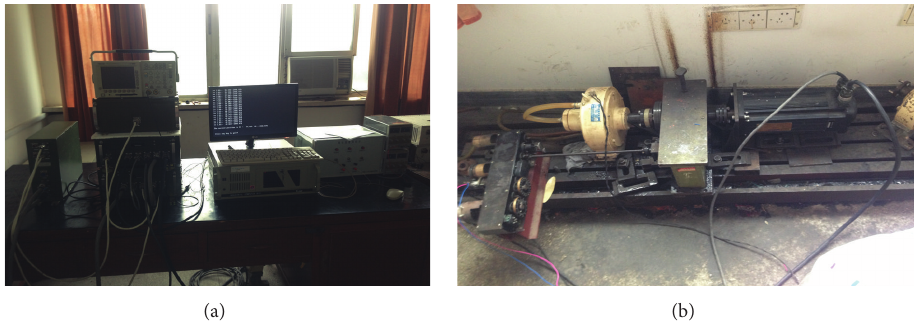
Figure 10: Photograph of the semiphysical simulation